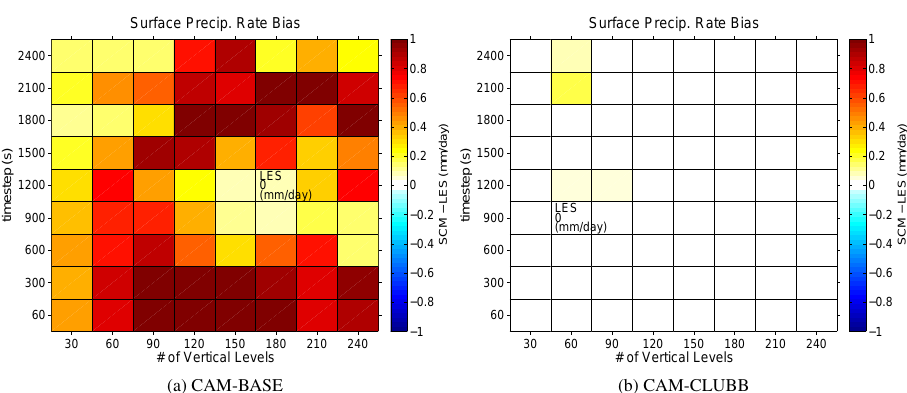
Fig. 6: Same as Fig. 1, except for the bias of surface precipitation rates from the ATEX case of cumulus under stratocumulus, averaged over hours 4–8.